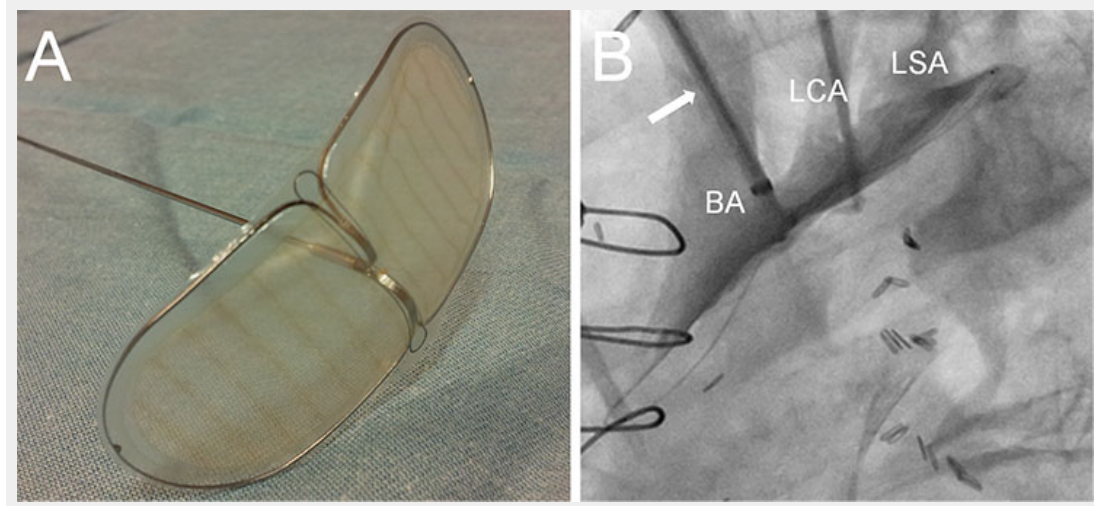
Figure 4 Example of an embolic protection device. The Embrella embolic deflector (A, Embrella Cardiovascular Inc, Wayne, PA) is introduced through the right radial artery to protect the brachiocephalic artery (BA), the left carotid artery (LCA) and the left subclavian artery (LSA) during the procedure.